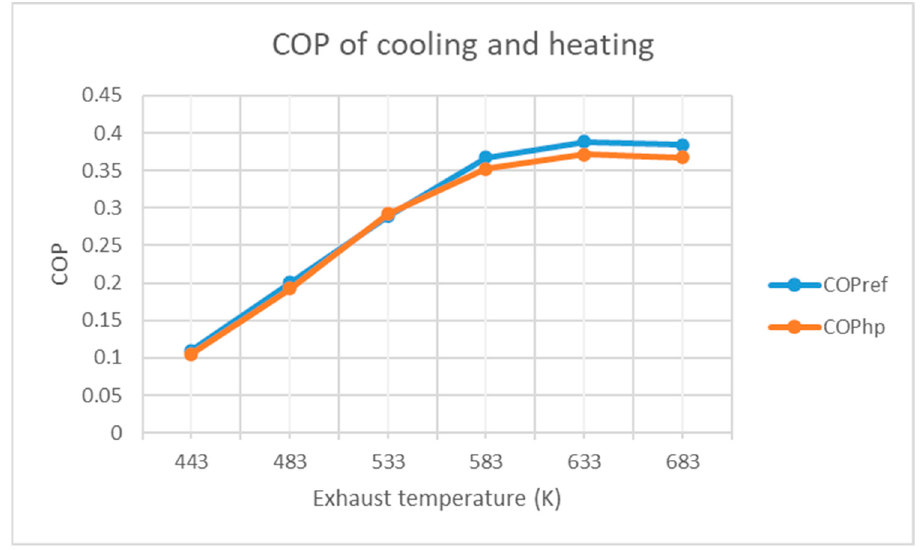
Figure 7. Evaporating and condensing heat vs. exhaust temperature.